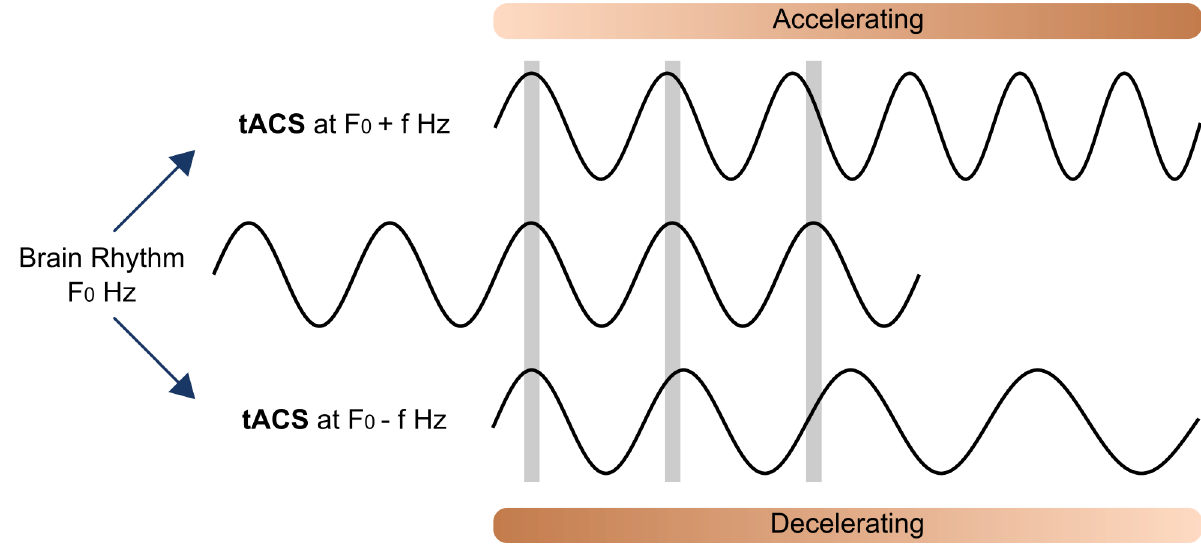
Fig 2. Theoretical framework of frequency entrainment. The basic brain rhythm F 0 is subjected to an external force (such as tACS) oscillating at a close frequency (F 0 ± f). If magnitude and timing of the external force are appropriate, the brain rhythm will accelerate or decelerate toward the frequency of the external force. tACS, transcranial alternating current stimulation.